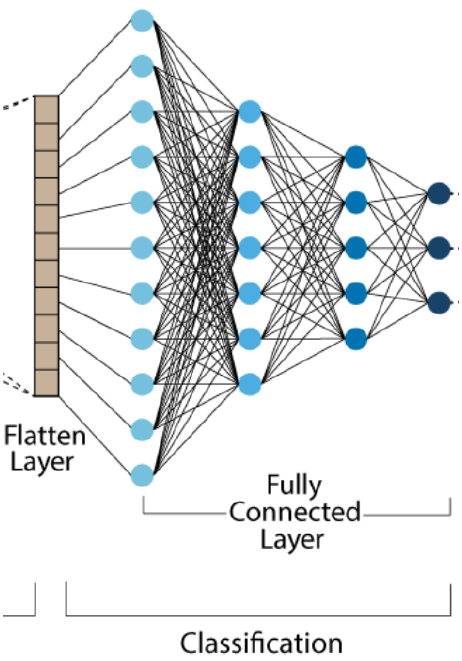
Figure 3. Fully connected